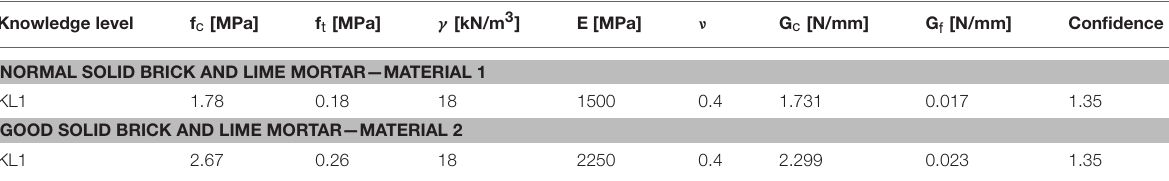
TABLE 1 | Mechanical characteristics of the main elements.